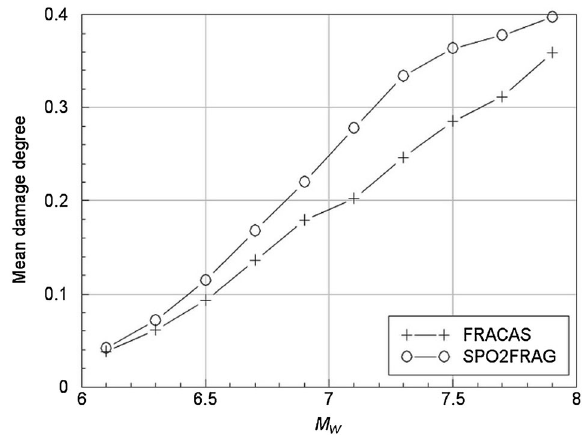
Fig. 8 Comparison of the mean damage degrees of structures in Bucharest, Romania, using the FRACAS and SPO2FRAG method- ologies as a function of earthquake